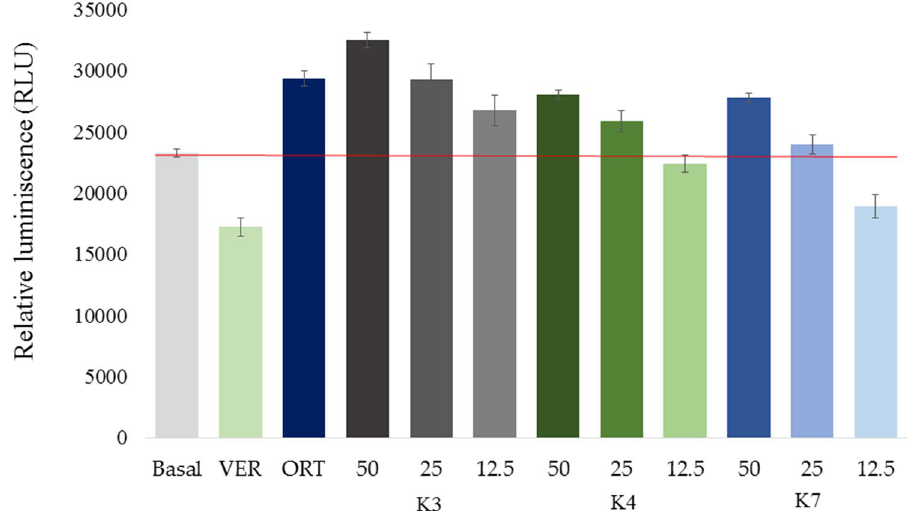
Figure 2. The modulation of P-glycoprotein (P-gp) ATPase activity by selected ketone-selenoesters. For the detection, P-gp kit with a human recombinant P-gp membrane fraction was used (P-gp-Glo assay system, Promega). The luminescent reaction was composed of P-gp membranes alone (without the addition of activator/inhibitor, Basal) or with the addition of verapamil (100 µM, P-gp activator), Na 3 VO 4 (100 µM, sodium orthovanadate, P-gp inhibitor) or tested compounds. Ketone-selenoesters K3 , K4 , and K7 were tested at a concentration range (12.5–100 µM) for their capacity to inhibit 100 µM verapamil-stimulated P-gp ATPase activity in a competitive mode. The red dividing line represents the interface between effect of inhibitors and activators. Data are expressed as the average of three repetitions with the standard error of the mean.